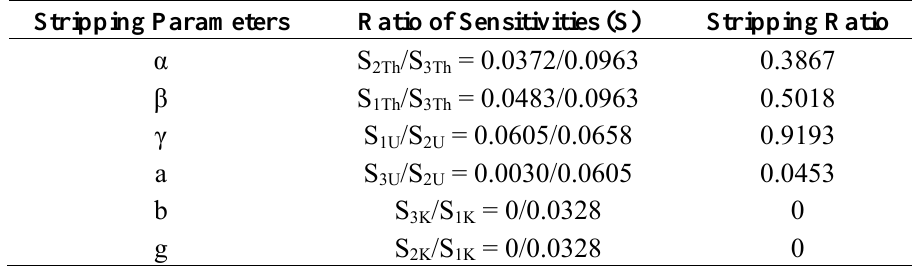
Table 4. Stripping ratios/factors calculated from the sensitivities of the spectrometer (sensitivity values were used from Table 3 for calculating their